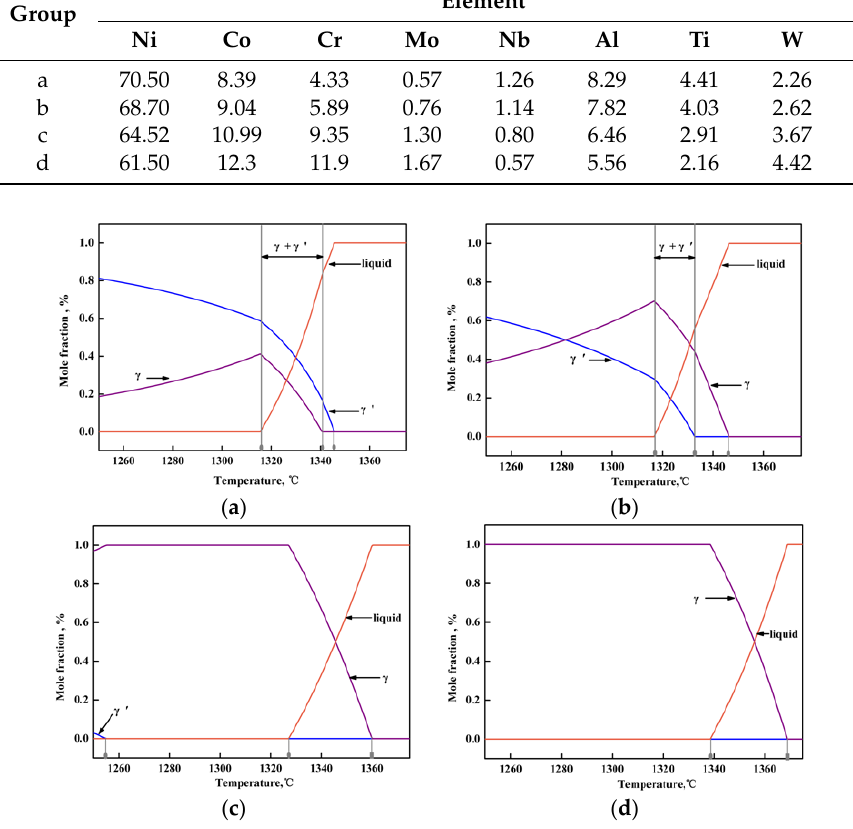
Figure 5. Calculated phase diagram based on chemical constituents in Table 2: ( a ) constituents of group a; ( b ) constituents of group b; ( c ) constituents of group c; and ( d ) constituents of group d.